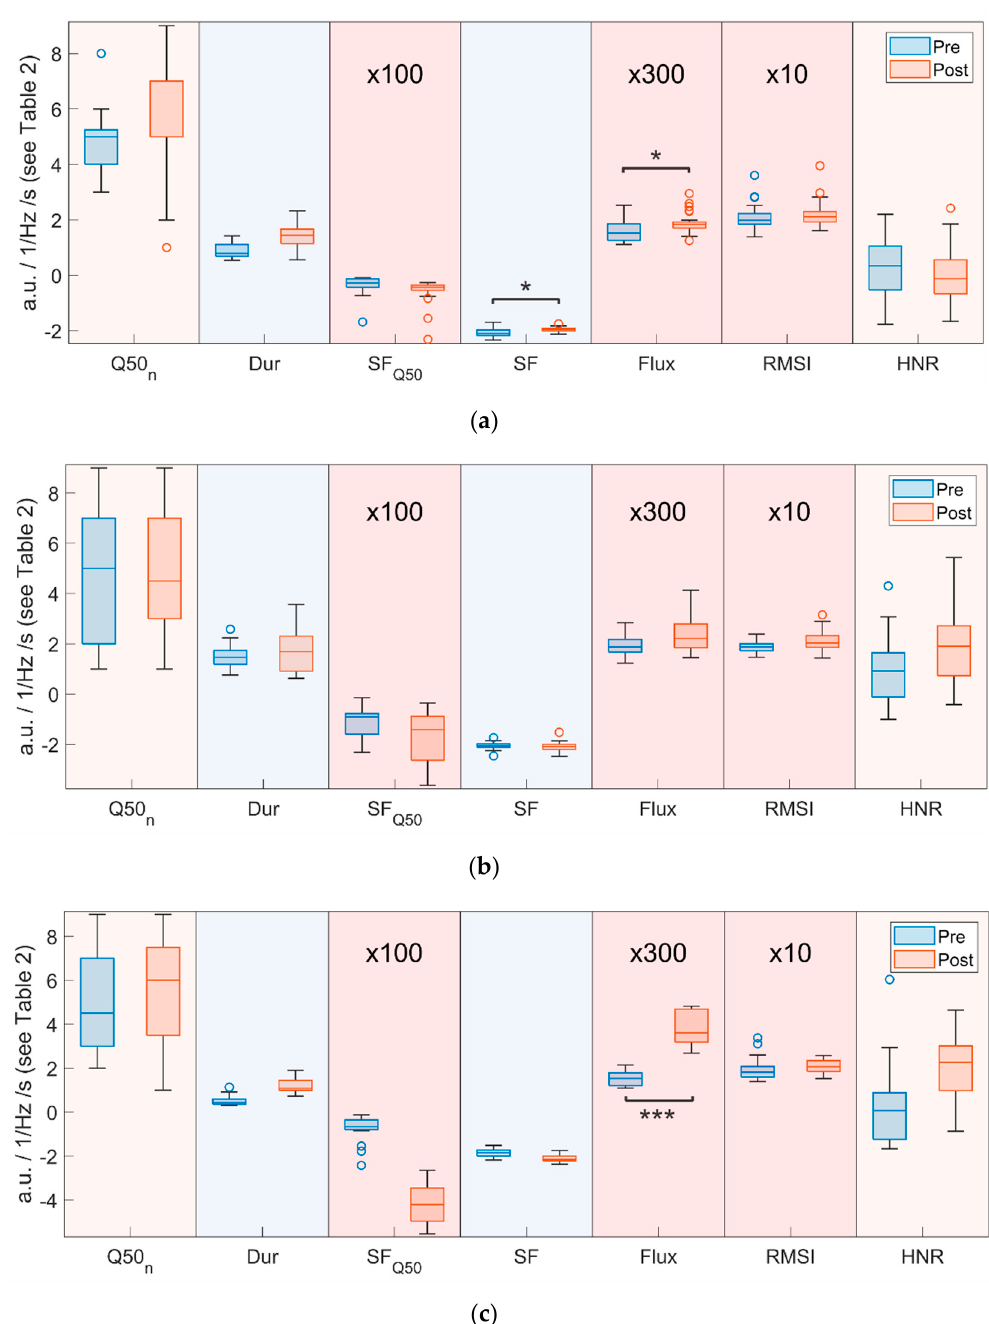
Figure 5. Boxplots of remaining parameters for ( a ) pig 1, ( b ) pig 2, and ( c ) pig 3 for pre- and post-surgery recordings. SF Q50 is scaled by a factor of 100, Flux by a factor of 300, and RMSI by 10. Statistically significant changes are marked with * symbols. (* p ≤ 0.05, *** p ≤ 0.001).